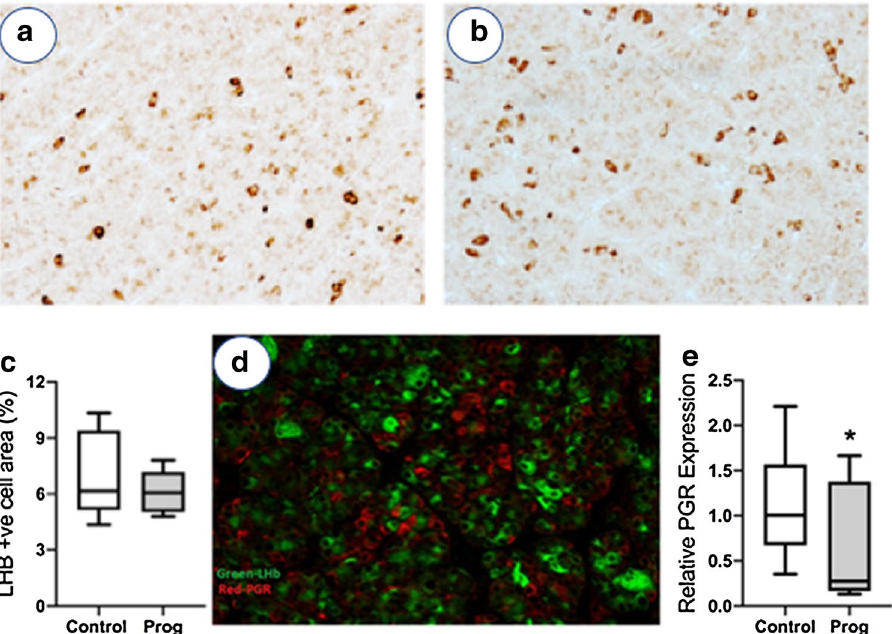
Figure 5. Assessment of gonadotrophs in the fetal pituitary at d75 gestation. Representative immunostaining for LHB (brown) in ( a ) the control fetal male pituitary and ( b ) the fetal male pituitary after maternal progesterone administration. ( c ) There was no difference in the area of gonadotroph staining (LHB) in the male fetal pituitary after maternal treatment with vehicle control (Control) or progesterone (Prog) (C = 10; P = 7). ( d ) Representative dual immunostaining of a control male fetal pituitary showing LHB (green) and PGR (red) showing that the gonadotrophs do not express PGR. ( e ) Maternal progesterone administration (Prog) decreased PGR expression in the male fetal pituitary (C = 10; P = 7). Box plot whiskers are lowest and highest observed values, box is the upper and lower quartile, with median represented by line in box. Unpaired, two-tailed Student’s t test was used for comparing means of two treatment groups with equal variances accepting P < 0.05 as significant (* P <